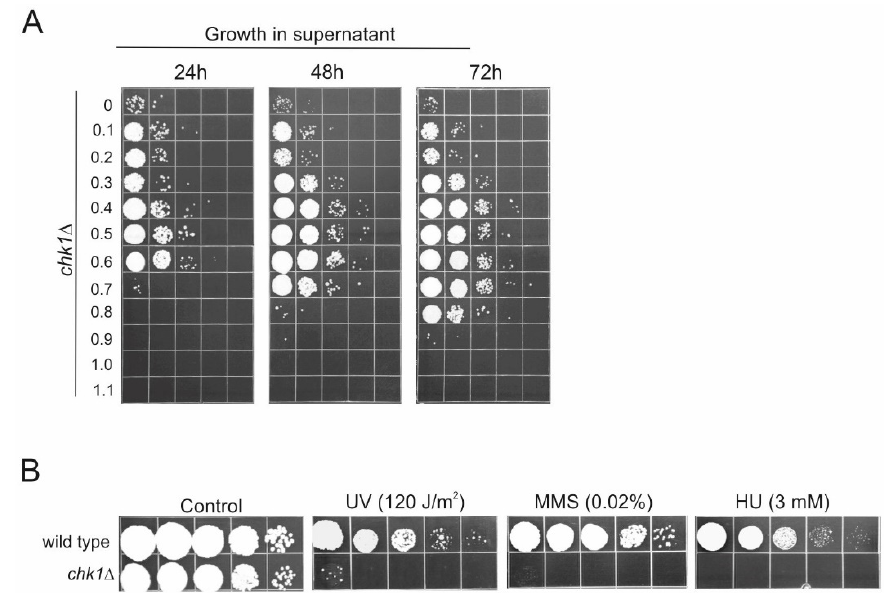
Figure 7. RUS phenotype of chk1 ∆ . ( A ) Growth of wild-type and chk1 ∆ mutant cells in cell-free supernatants derived from treatments of wild-type cells (4 × 10 7 ) with increasing peroxide doses. Ten-fold serial dilutions were spotted on solid medium in 24 h-intervals. ( B ) Response of chk1 ∆ to genotoxic agents. Ten-fold serial dilutions of mutant were plated on solid medium then irradiated with indicated dose of UV or else plated on medium containing MMS or HU. Experiments were performed three times and representative results are shown.